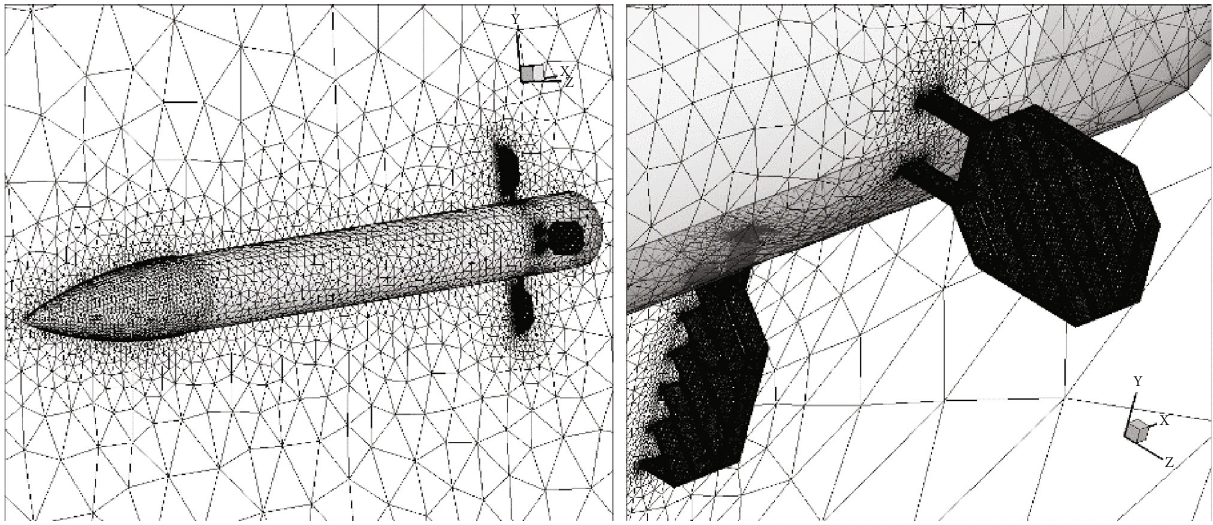
Figure 7: Grid tail meshing strategy.